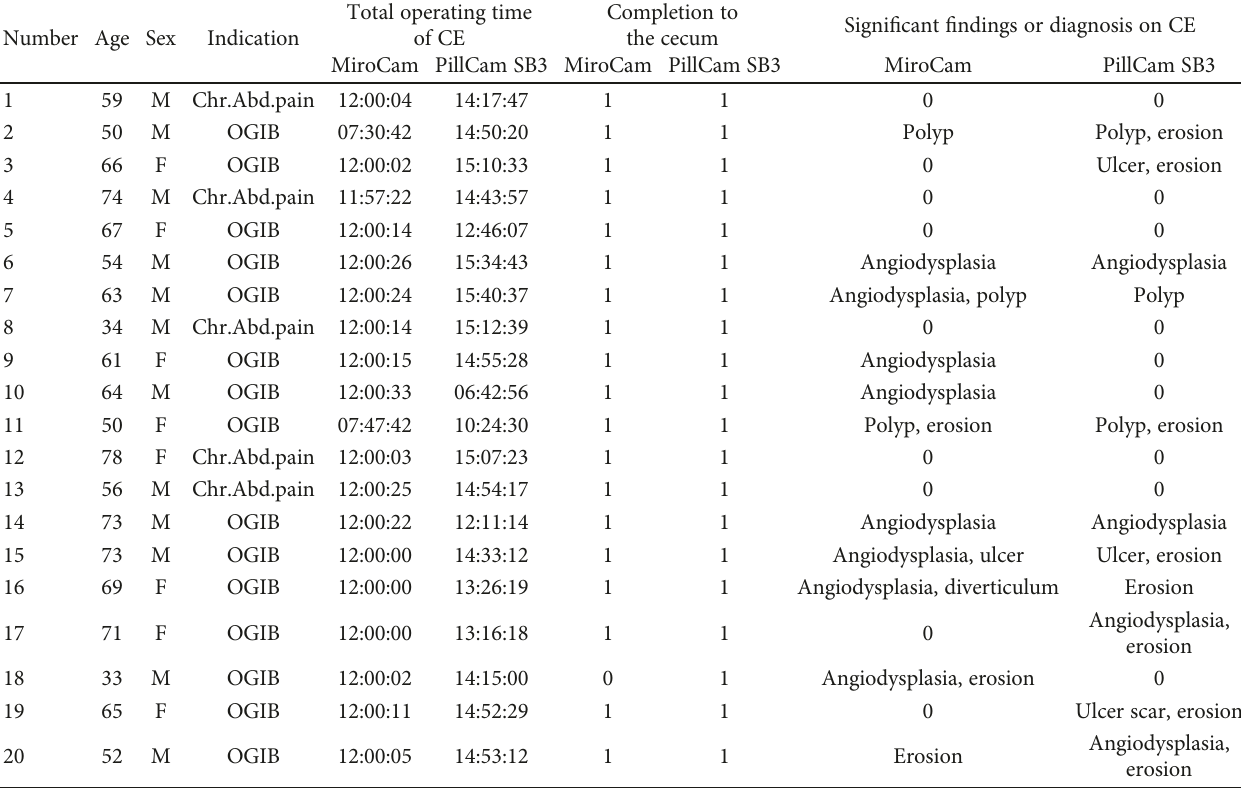
Table 1: Characteristics of patients and technical information on MiroCam and PillCam SB3 capsule endoscopes. Number Age